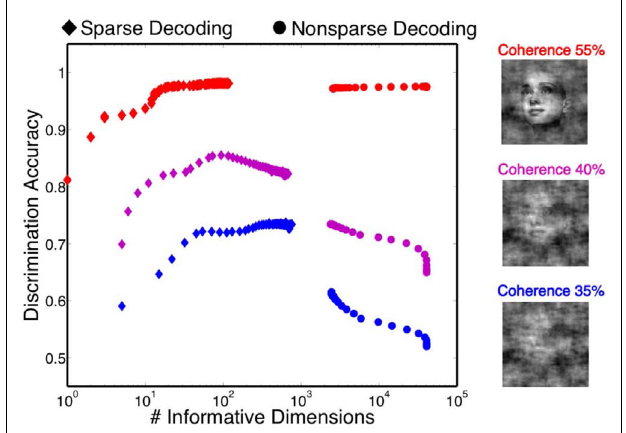
FIGURE 10 | Discrimination accuracy for both sparse and non-sparse decoding strategies. Decoding is shown for three different coherence levels while sweeping the hyperparameter that controls the amount of regularization. Sparse decoding always yields fewer informative dimensions while also having greater discrimination accuracy for each of the three coherence